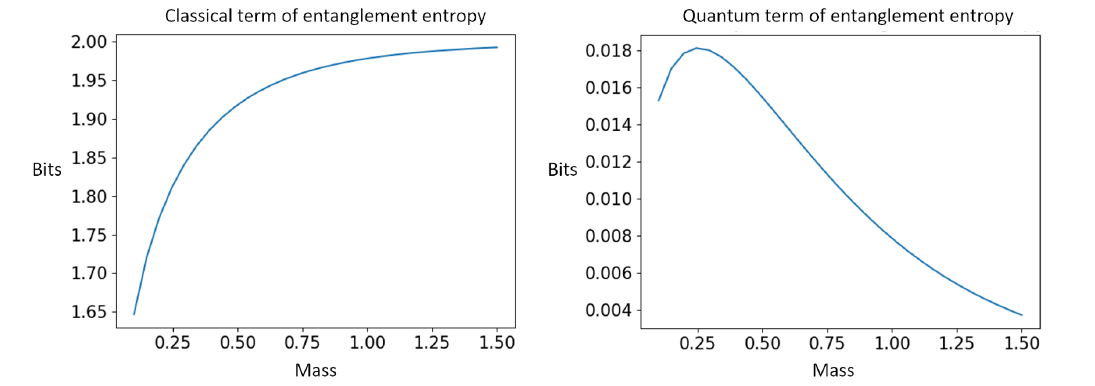
Figure 3 . Entanglement entropy with respect to a partition of target space, for two coupled oscillators governed by the Hamiltonian in eq.